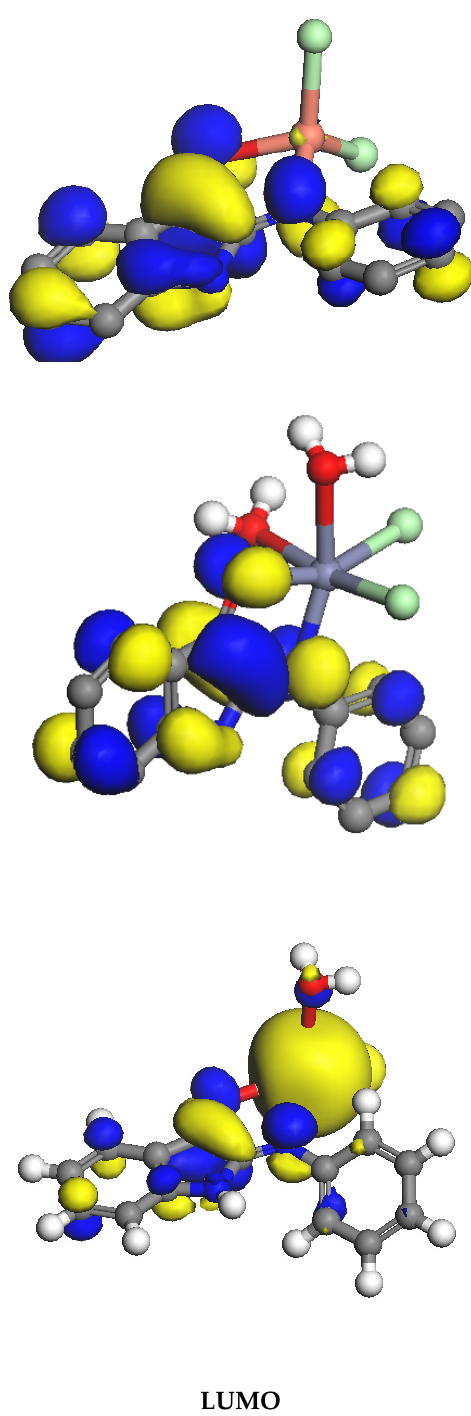
Figure 4. Occupied higher energy and unoccupied lower energy molecular orbitals of Cr(III), Mn(II), Fe(III), Co(II), Ni(II), Cu(II), Zn(II), and Cd(II) complexes.